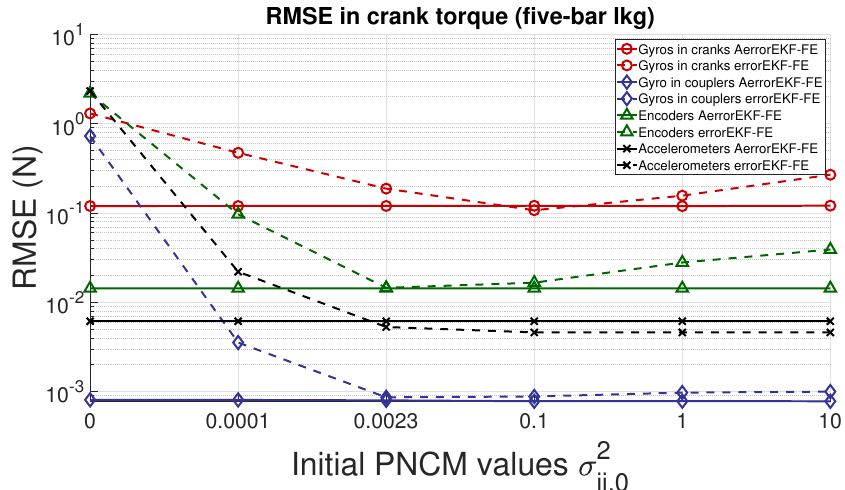
Figure 14. RMSE of the norm of the forces acting on the two cranks provided by the observers for the five-bar